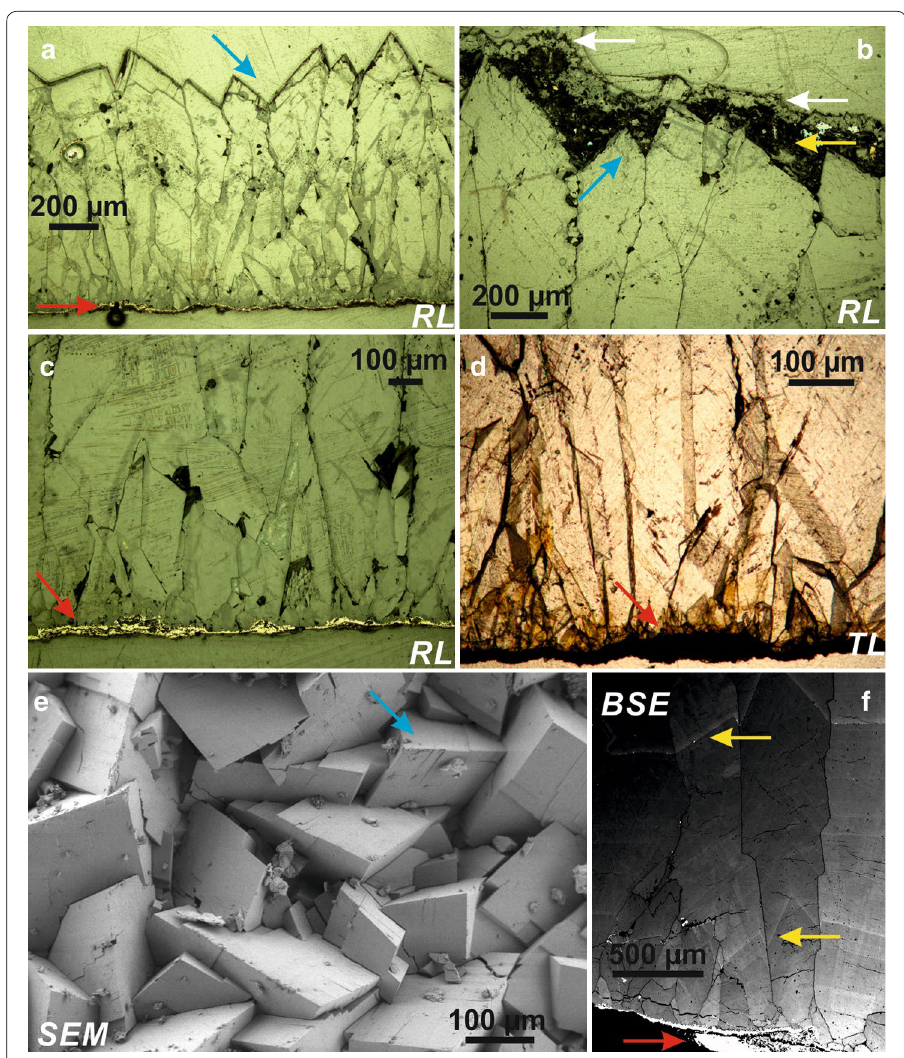
Fig. 4 Microscopic characterization of the carbonate scale-fragment fabric. a Reflected light (RL) cross- section showing a basal sulfide corrosion layer ( red arrows ), columnar Mg-calcite crystals, and rhombohe- dral crystal tips forming a rough scale growth surface ( blue arrows ). b RL image showing a layer of detrital particles (variable thickness, yellow arrows ) on the former calcite growth surface ( blue arrow ) and